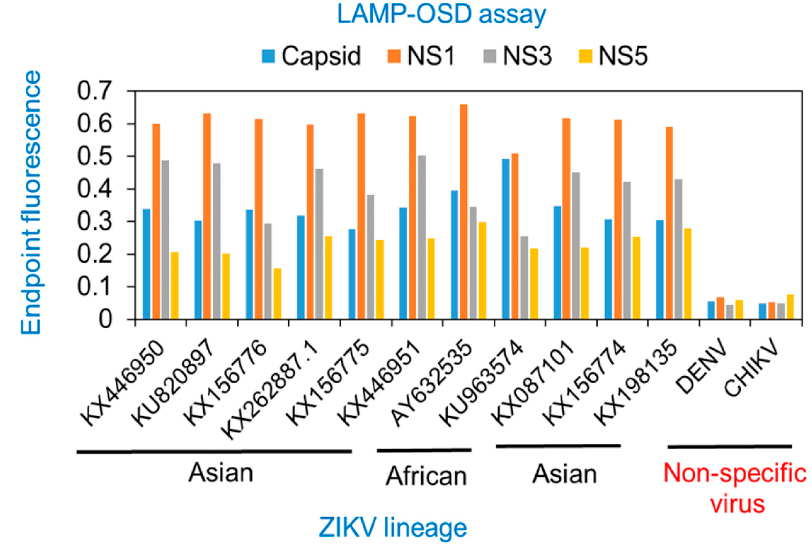
Figure 3. Detection of Asian and African lineage ZIKV using degenerate reverse transcription LAMP-OSD assays. Genomic RNA from DENV, CHIKV, or Asian or African lineage ZIKV (indicated by their GenBank accession numbers) were used as templates for amplification in degenerate RT-LAMP-OSD assays for Zika virus capsid , NS1 , NS3 , and NS5 genes. OSD fluorescence signals measured at amplification endpoint using LightCycler 96 real-time PCR machine are depicted as blue ( capsid ), orange ( NS1 ), gray ( NS3 ), and yellow ( NS5 ) bars. Representative results from three replicate experiments are